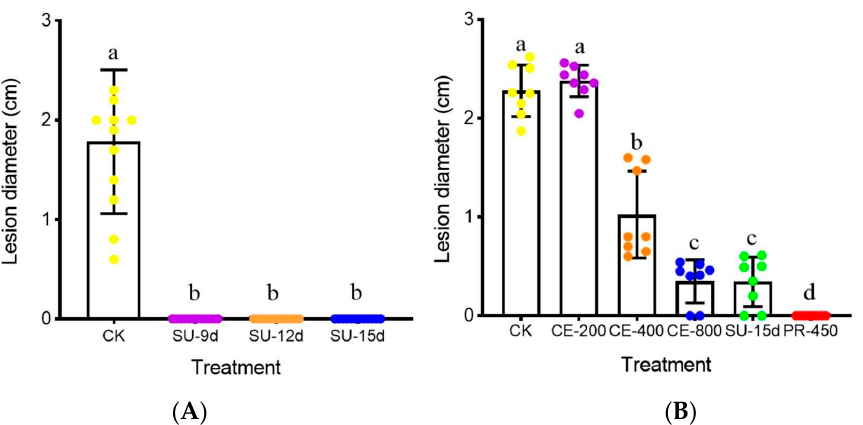
Figure 7. Efficacy of the cultures of Simplicillium lamellicola JC-1 and the crude extract in the suppression of infection by Sclerotinia sclerotiorum on detached leaves of oilseed rape (20 °C, 2 d). CK , control; SU-9d , SU-12d and SU-15d , supernatants from 9-, 12- and 15-day-old PDB cultures, respectively;